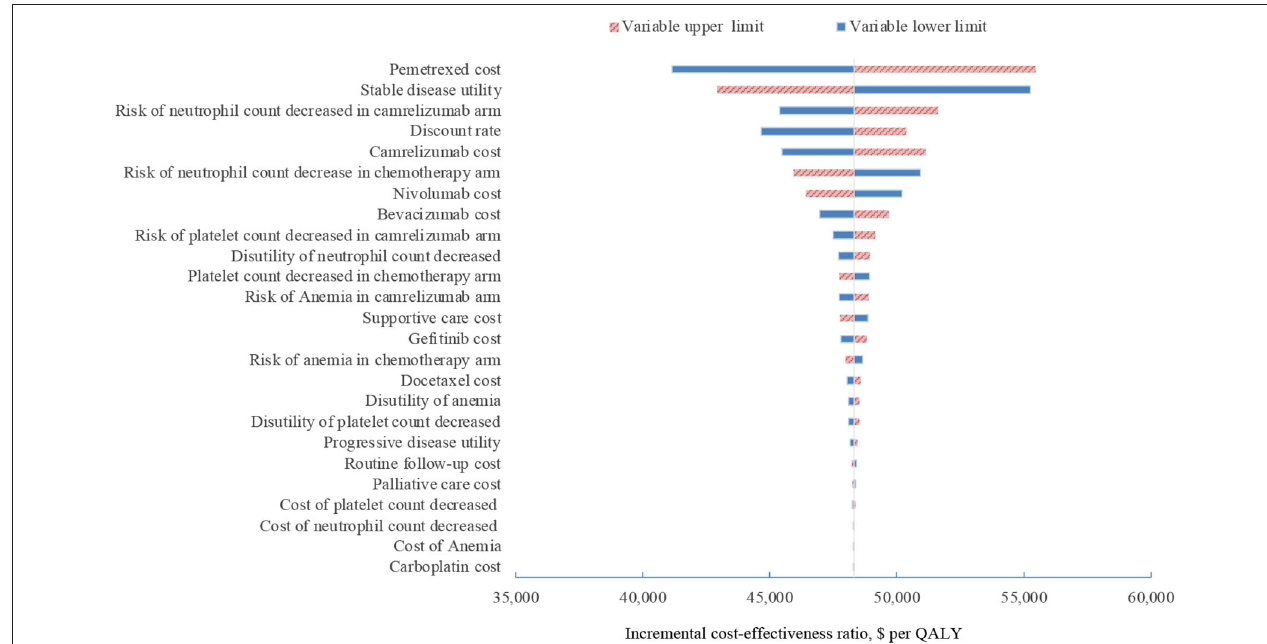
FIGURE 2 | Deterministic sensitivity analysis for the subgroup analysis. QALY, quality-adjusted life-years.